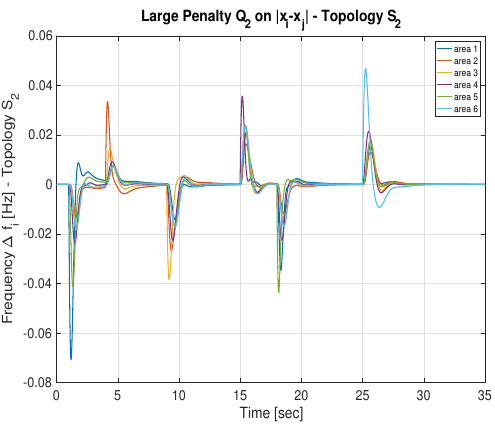
Figure 14. Frequency deviation ∆ f i response for i = 1, · · · ,6, topology S 2 , control tuning with Q 2 = 200 Q 1 , uncertain